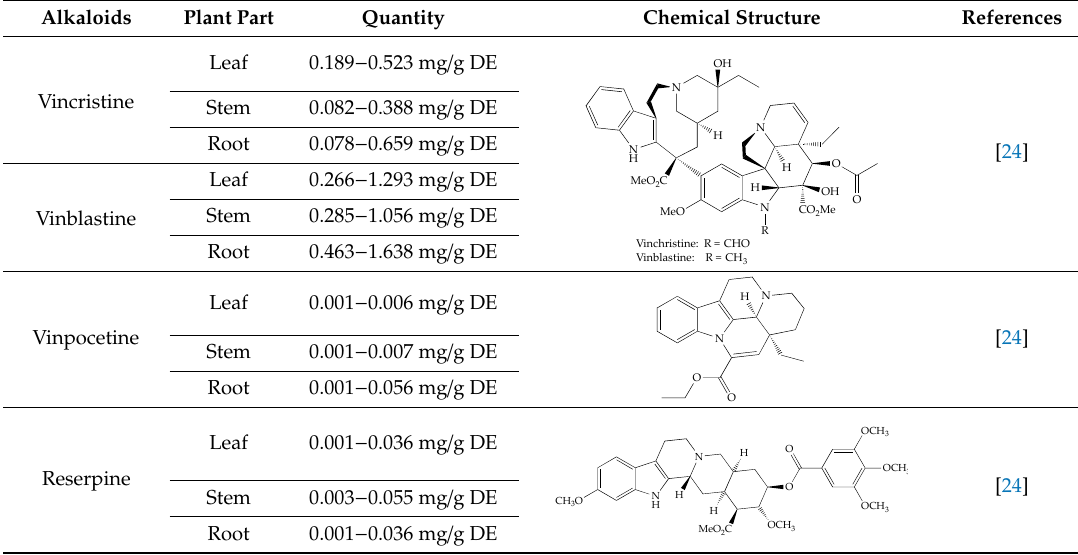
Table 2. Identified alkaloids in C. roseus .